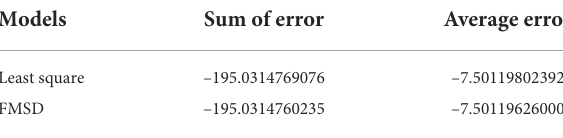
TABLE 5 Relative error analysis using the data of the 27th